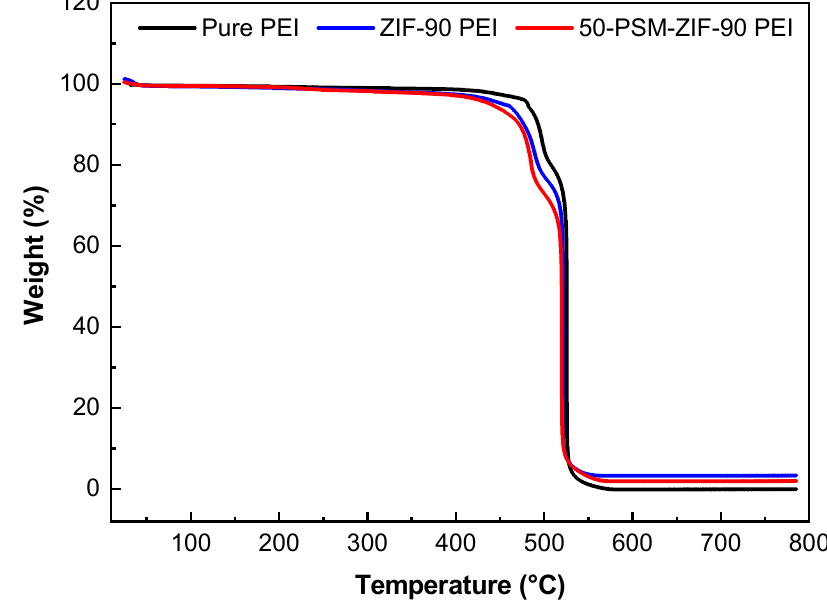
Figure 9. TGA of the pure PEI, ZIF-90 PEI and 50-PSM-ZIF-90 PEI membranes.